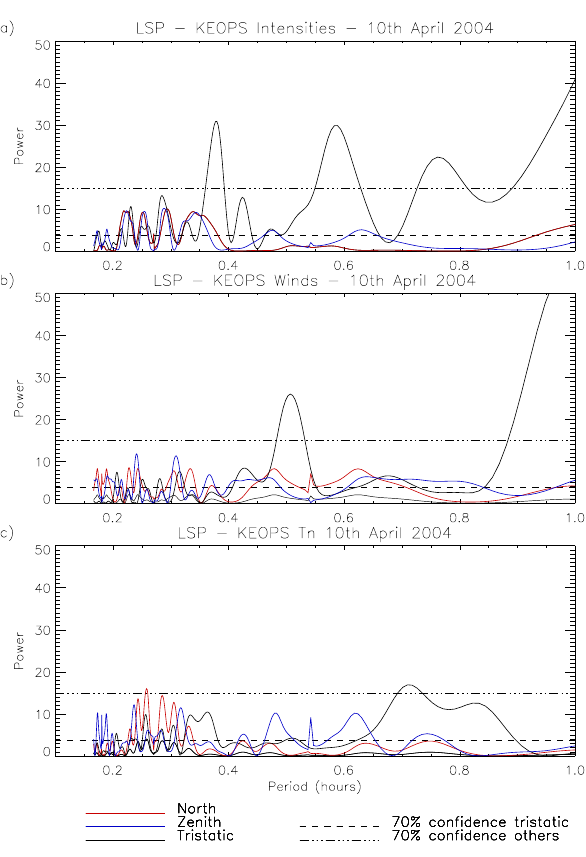
Fig. 11. Lomb-Scargle Periodogram up to periods of 1h, from KEOPS data on 11 April 2004: (a) intensities, (b) winds, and (c) temperatures. The low resolution look directions are scaled by a factor of